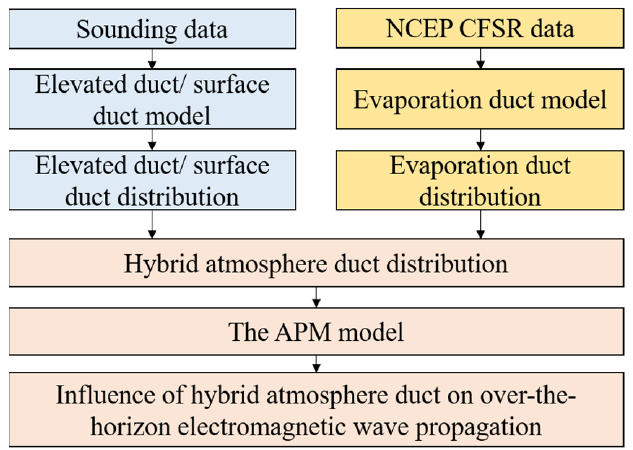
Figure 1. Flow chart for this study.